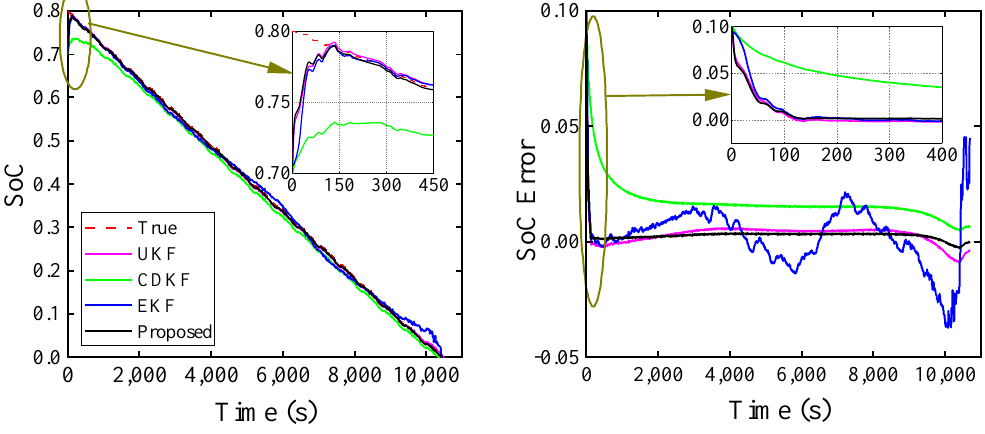
Figure 11. The initial SoC guess was 0.7 under the US06 condition.